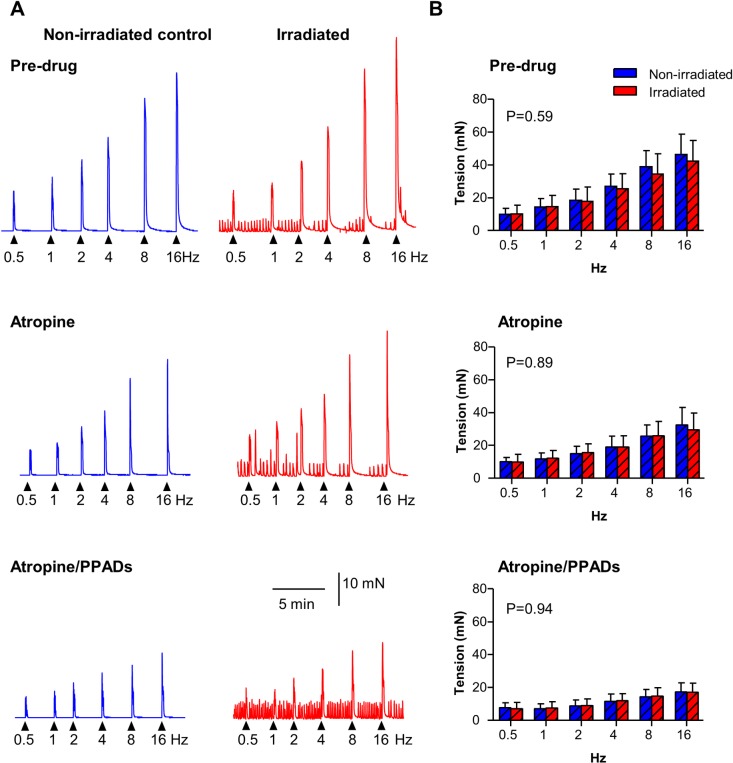
Neurogenic contractions in mucosa-free strips are not affected by irradiation.(A) Original traces of EFS-evoked neurogenic contractions in non-irradiated controls (blue) and 20Gy irradiated mucosa-free strips (red). Atropine (1μM) reduced neurogenic contractions at all frequencies and subsequent addition of PPADs (100μM) caused further reduction. (B) Summary graphs (mean ± SD) showing that neurogenic contractions in irradiated strips (N = 6, n = 12) were not different than non-irradiated controls (N = 6, n = 12) across the force-frequency range (P = 0.59) and at each frequency tested (post-hoc test). Atropine (N = 6, n = 12) and subsequent addition of PPADs (N = 6, n = 12) affected both non-irradiated and irradiated strips similarly 2-way repeated measures ANOVA, Bonferroni post-hoc test. * denotes P<0.05.